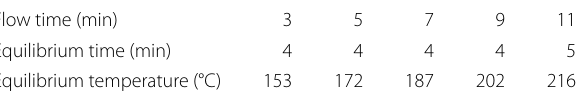
Table 6 Equilibrium time and equilibration temperature after different flowing